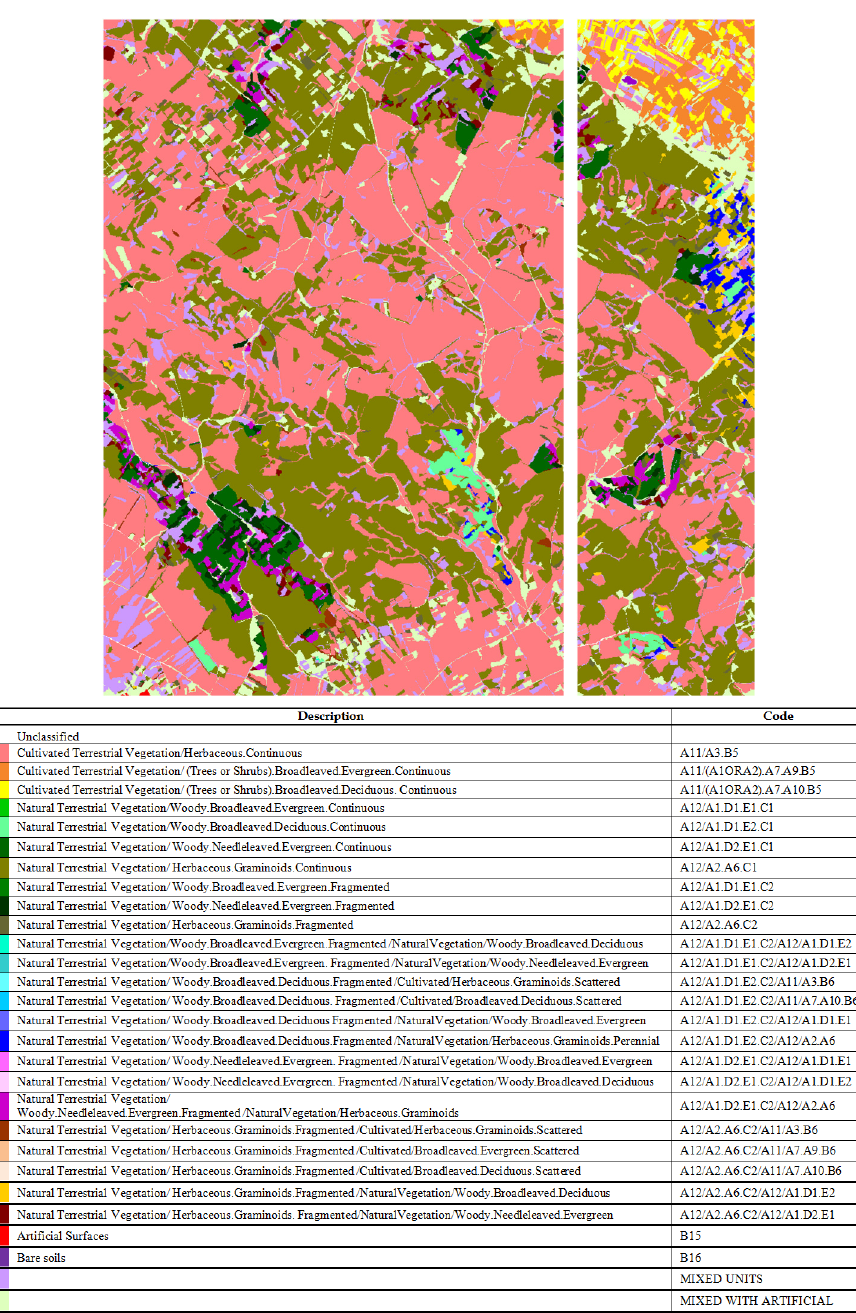
Figure 10. Subsets of the final LO map.